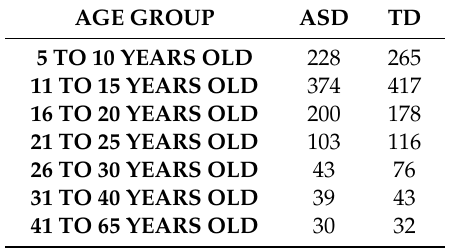
Table 1. Number of subjects for each age group extracted from